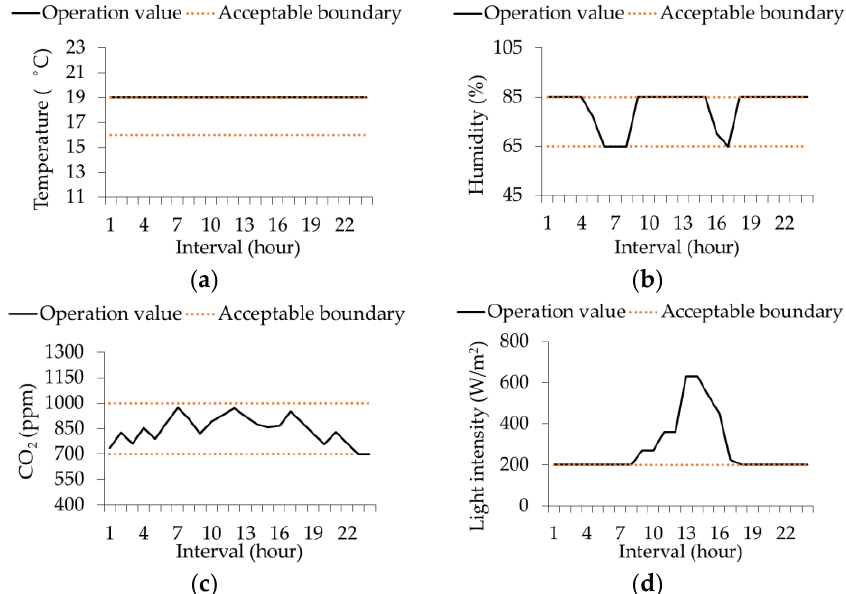
Figure 4. Environmental control of a building microgrid with rooftop greenhouse: ( a ) Temperature; ( b ) Humidity; ( c ) CO 2 concentration; ( d ) Light intensity.